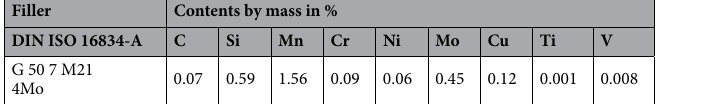
Table 3. Chemical composition of the filler 26 .